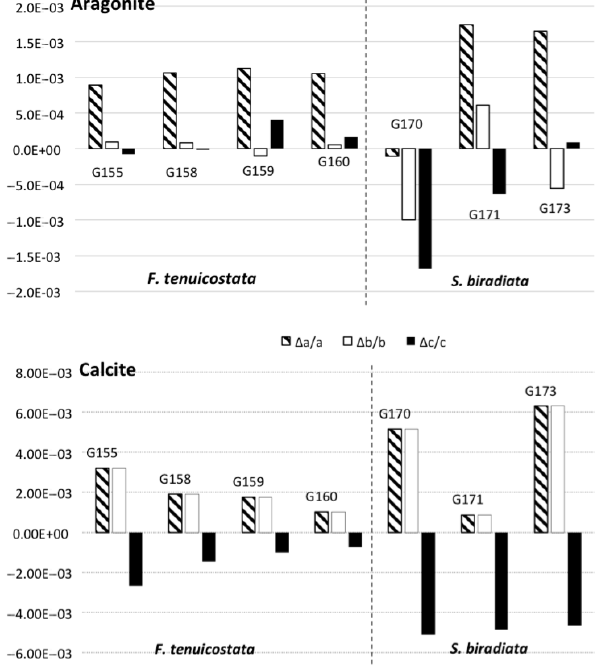
Figure 4. The aragonite lattice distortion presented as (cid:49)a/a , (cid:49)b/b and (cid:49)c/c compared to the mineral standard (Pokroy et al., 2006) for four specimens of F. tenuicostata and three of S. biradiata . The y axis indicates the amount of distortion compared to ICSD-98- 015-7993 mentioned above. Negative distortions are indicative of shrinking, and positive distortions are indicative of